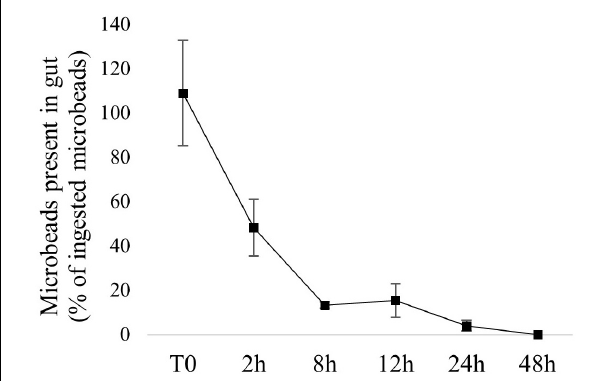
FIGURE 4 | Microbead depuration over time in fish exposed via trophic chain. Values are numbers of microbeads recovered in fish gut, expressed as a percentage of ingested microbeads (average ± SE; n =